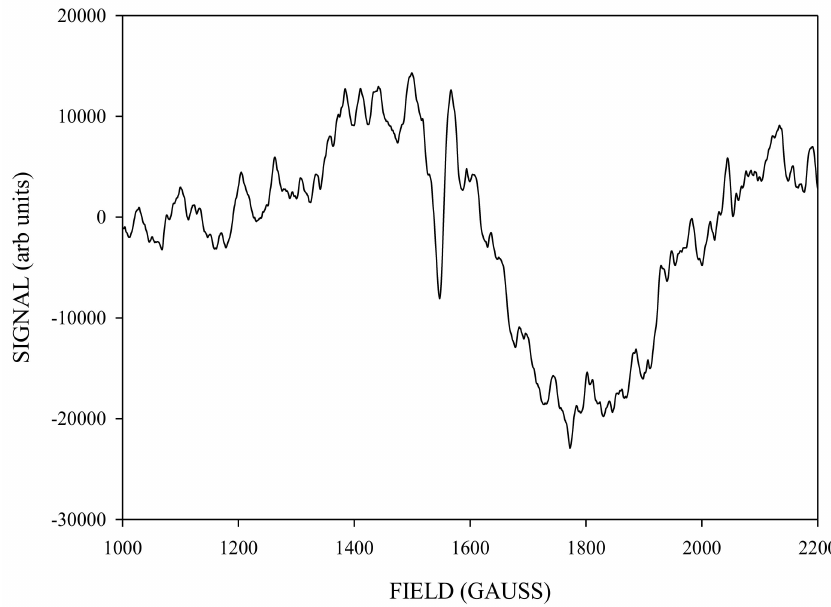
Figure 8. The X-band CW-EPR difference g 4.1 spectrum obtained corresponding to Figure 7 (140 K NIR difference) minus Figure 6 ( ≈ 65% of 240 K difference)